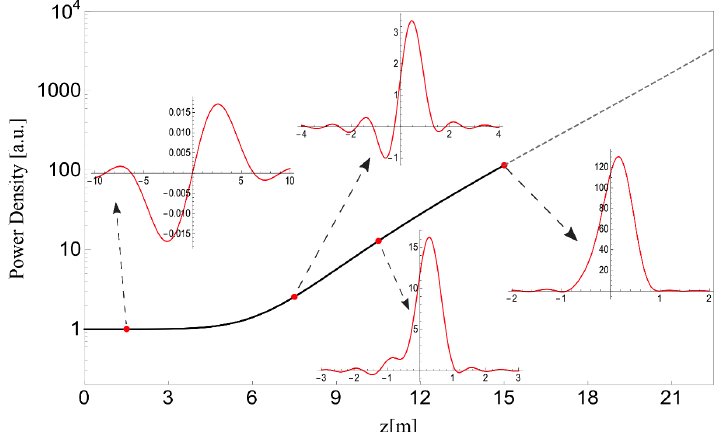
Figure 4. Power density (a.u.) vs. z and gain function “measured“ at different points inside the undulator. Above the last point, where the dotted curve starts, the small signal gain is not properly defined because the small signal approximation does not strictly apply. The curves have been derived for the parameters ρ 0 = 6.8 · 10 − 4 and λ u = 5 cm. The small signal gain coefficient goes from 5.35 · 10 − 3 to